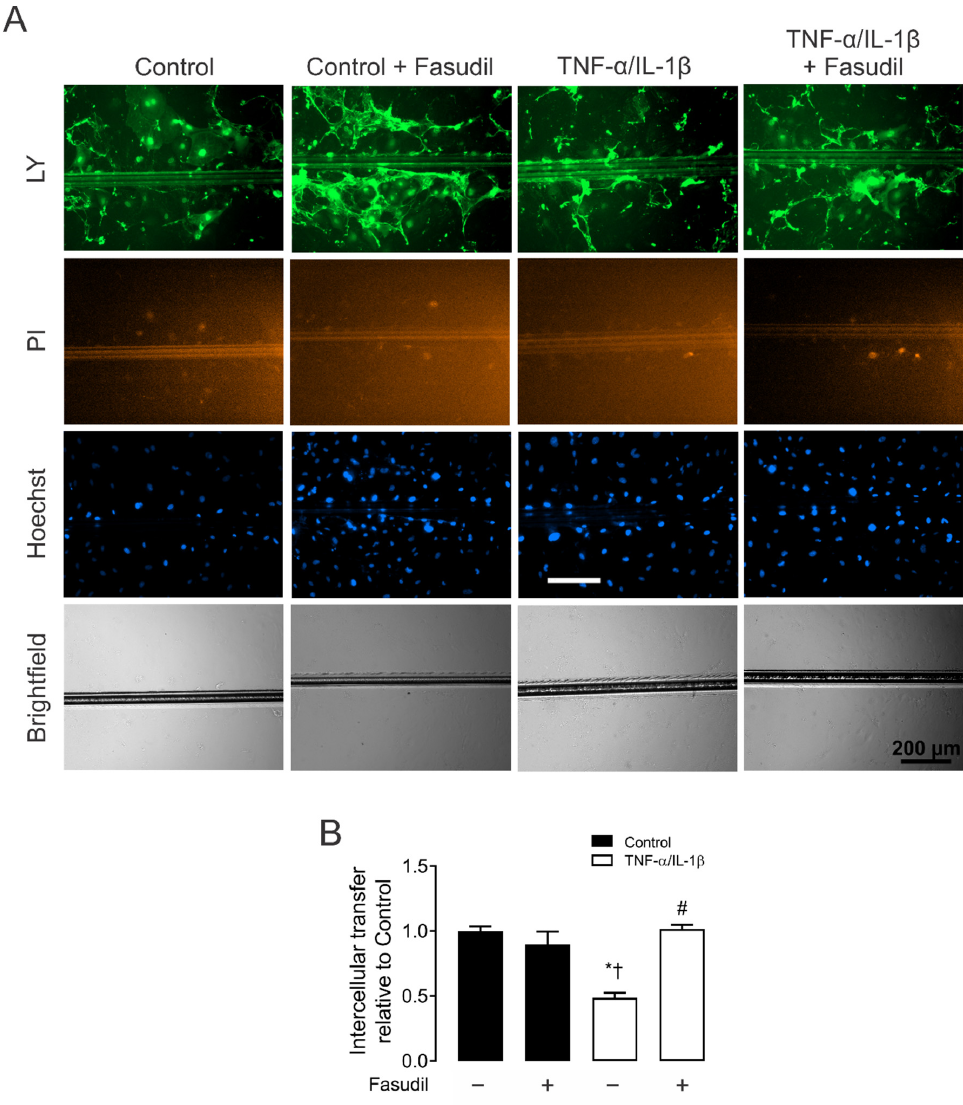
Figure 3. Fasudil prevents the TNF- α /IL-1 β -induced decrease in primary mesangial cell coupling. ( A ) Representative fluorescence micrographs of SL/DT with Lucifer yellow (LY) by primary MCs under control conditions, 72 h after exposure to TNF- α /IL-1 β (10 ng/mL) or treatment with Fasudil (15 µ M). For each experiment are shown representative images of communicating cells stained with LY, dead cells along the cut stained with propidium iodide (PI), the total cells stained with Hoechst. Bar = 200 µ m. ( B ) Averaged data normalized to control (black bars) of SL/DT with LY by primary MCs after 72 h of treatment with TNF- α /IL-1 β (white bars) or in combination with Fasudil. Each bar represents the mean value ± SEM of 3 independent experiments. Statistical significance, * p < 0.05 vs. Ctrl; † p < 0.05 vs. Control + Fasudil; # p < 0.05 vs. TNF- α /IL-1 β